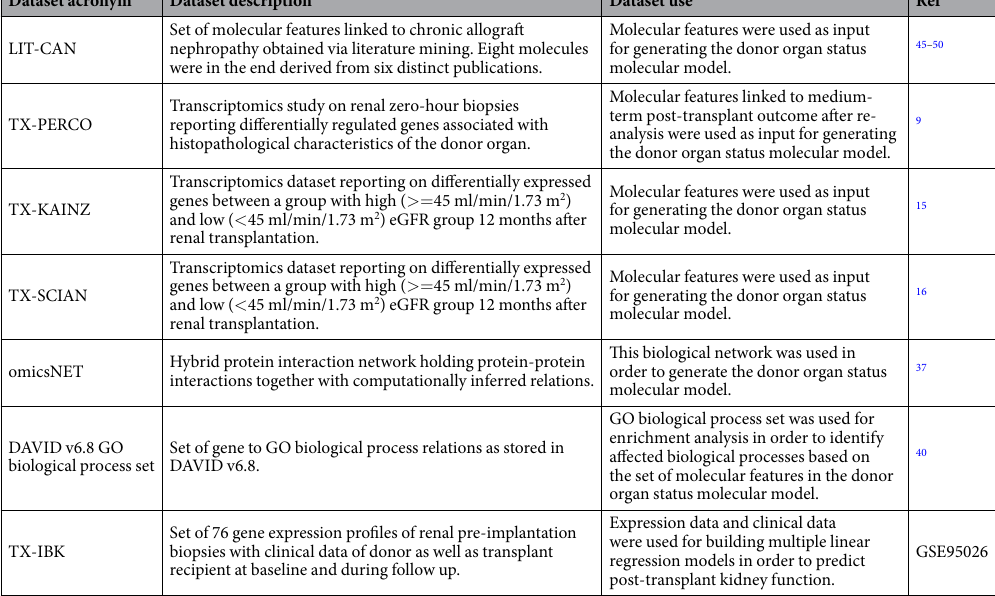
Figure 1 outlines the data analysis workflow along with key results on identified molecular markers and biological processes. The donor organ molecular model.